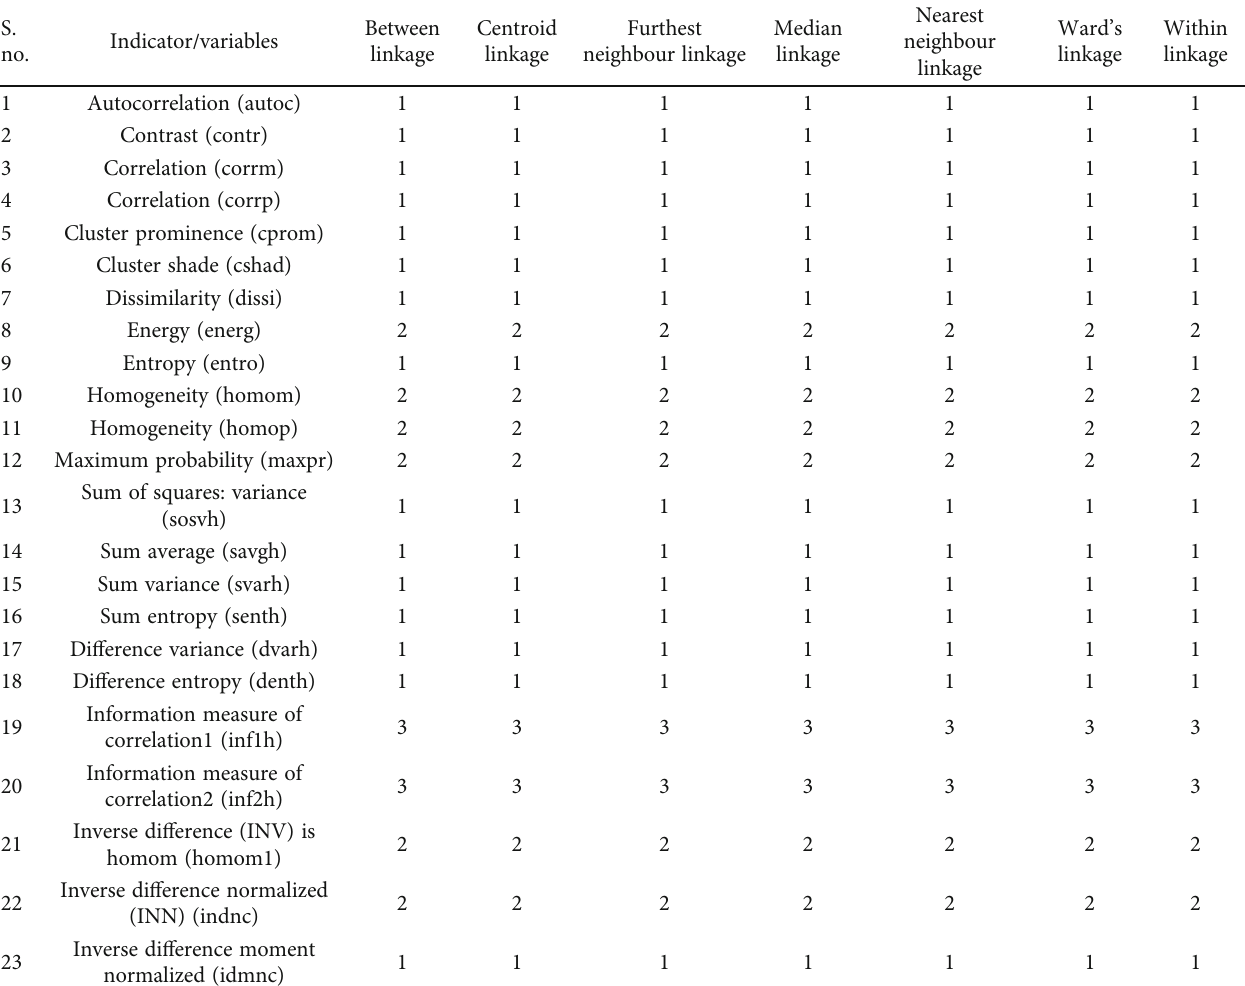
Table 5: Comparative cluster membership analysis with di ff erent